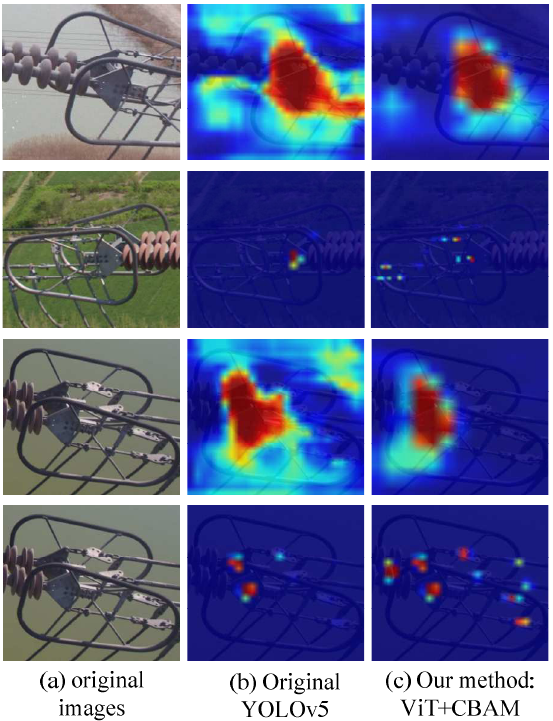
Figure 16. Visualization results of thermal diagram of model attention.